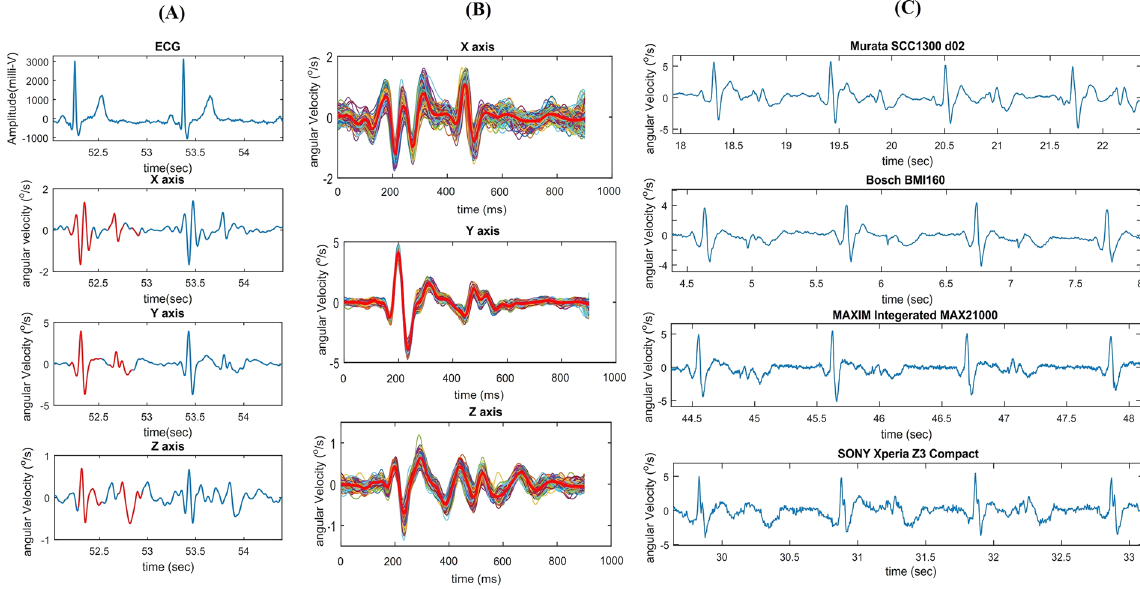
Figure 2. Typical three dimensional GCG waveforms from x , y , and z axes of rotation. 3-axis GCG morphologies and reference ECG ( A ). 3-axis ensemble averaged GCG morphologies ( B ). GCG y -axis waveforms obtained using different sensors ( C